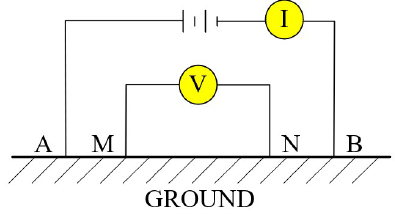
Figure 1. Principle of the basic electrical method.